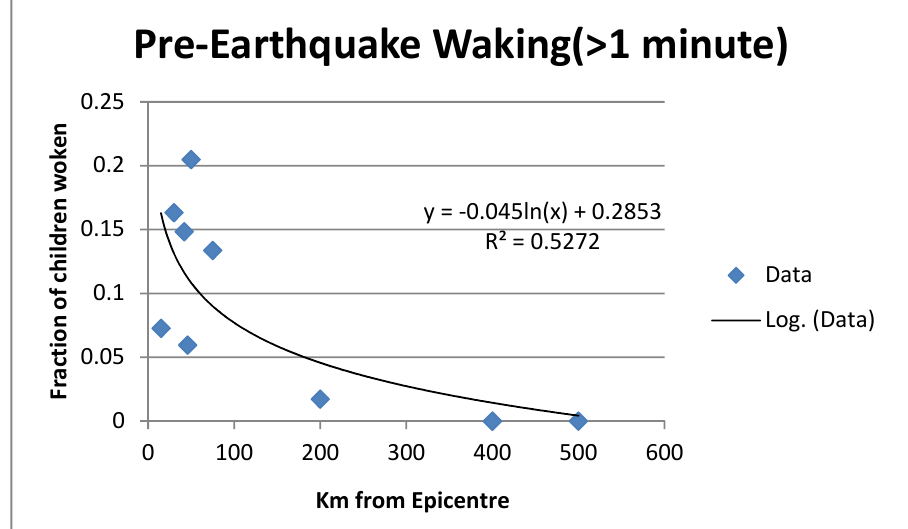
Figure 2. Log fit to data of children who woke more than a minute before the quake.